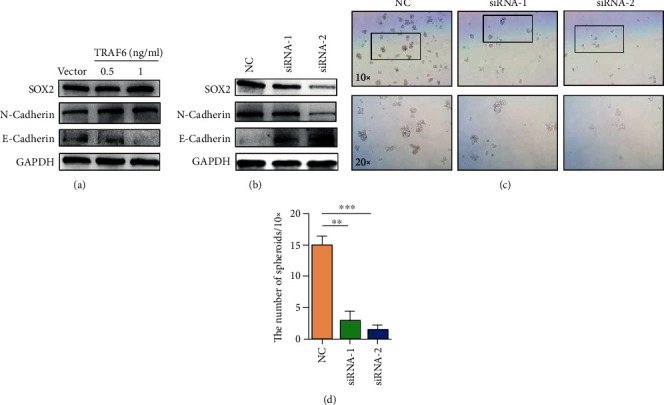
TRAF6 promoted stemness and inhibited differentiation in gastric cancer cells. (a) Western blot assay for the expressions of SOX2, N-cadherin, and E-cadherin in vector and TRAF6 plasmid-transfected HGC-27 cells. (b) Western blot assay for the expression of SOX2, N-cadherin, and E-cadherin in transfected NC and TRAF6 siRNA-transfected HGC-27 cells. (c) Mammospheres generated from single-cell cultures of NC and TRAF6 siRNA-transfected HGC-27 cells, imaged after 6 days of suspension culture (SF medium). (d) Number of mammospheres in (c) (mean ± SD numbers of spheres; n = 3, ∗∗p < .005).